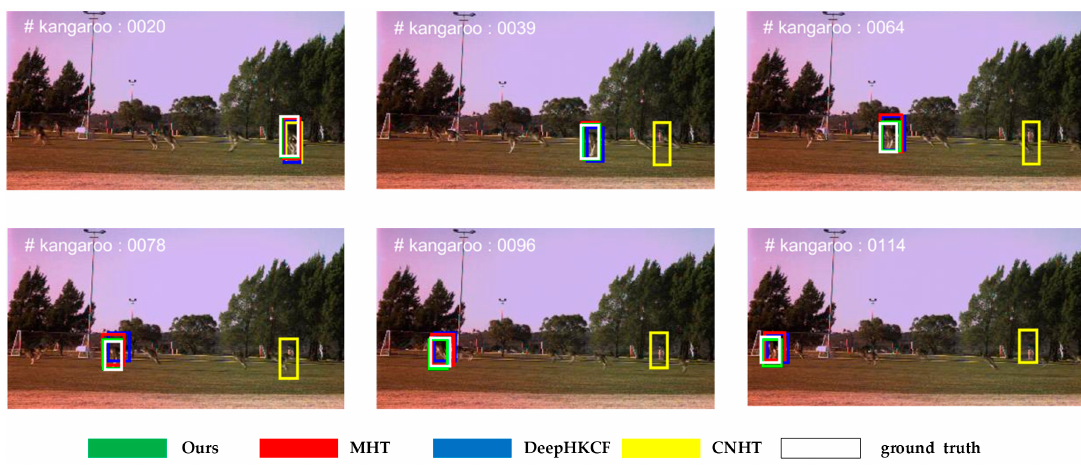
Figure 13. Tracking result of the kangaroo sequence.